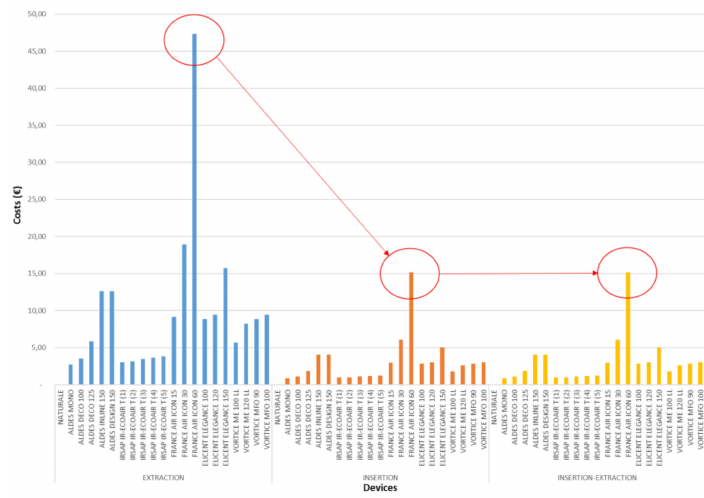
Figure 10. Relationship between management costs for the three systems of CMV. NB: all the figures use dots and commas as per Italian